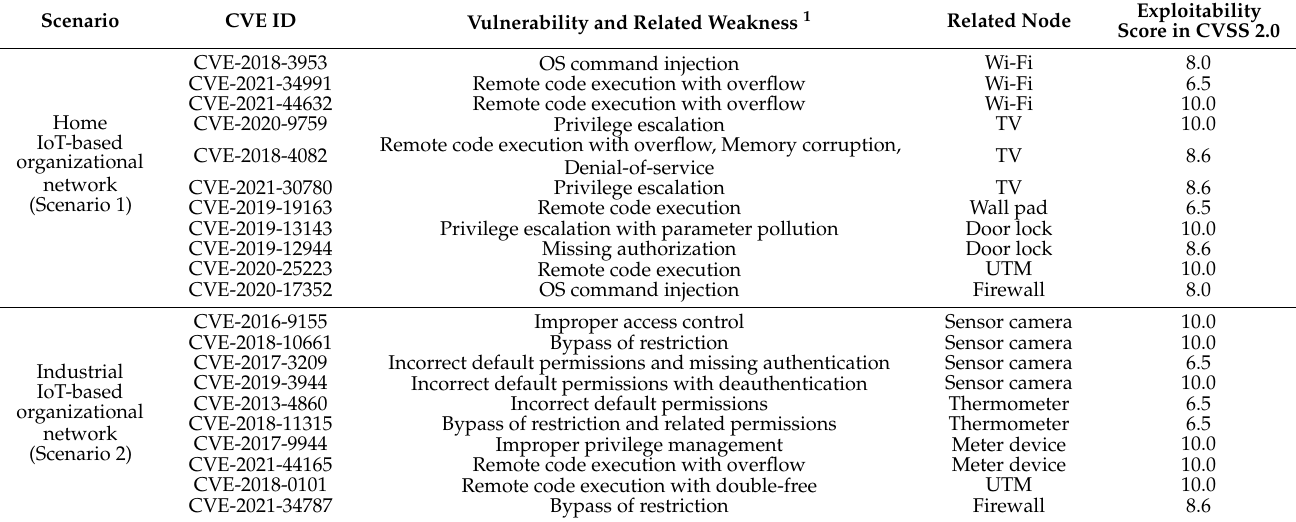
Table A3. CVE and CVSS-based vulnerability table based on IoT